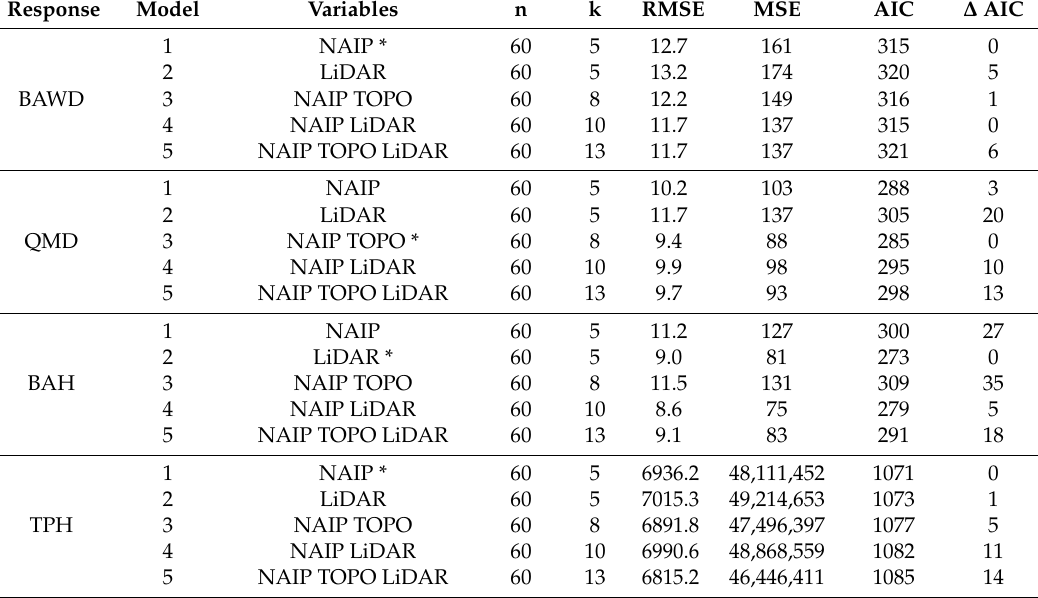
Table 2. Out of bag model fit, comparison, and rank for basal area weighted diameter (BAWD), quadratic mean diameter (QMD), basal area per hectare (BAH), and trees per hectare (TPH), where n = the number of observations, k = the number of randomly selected variables, RMSE = root mean squared error, MSE = mean squared error, AIC = Akaike Information Criterion, and ∆ AIC = departure from minimum AIC score. * denotes best fitting model with the fewest number of predictor variables.